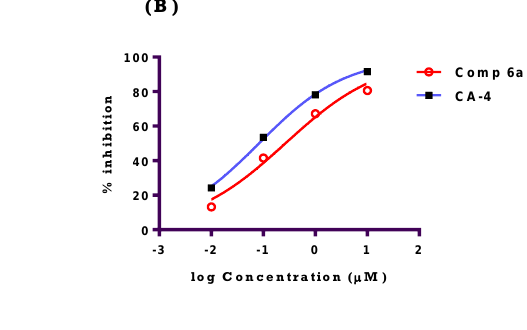
6 of 16 Figure 2. ( A ) Dose response curve for in vitro HDAC inhibitory activity of tetraamide 6a and SAHA against HDAC1 and HDAC2 isoforms. ( B ) Graphical representation for in vitro HDAC inhibitory activity of tetraamide 6a and SAHA against HDAC1 and HDAC2 isoforms .